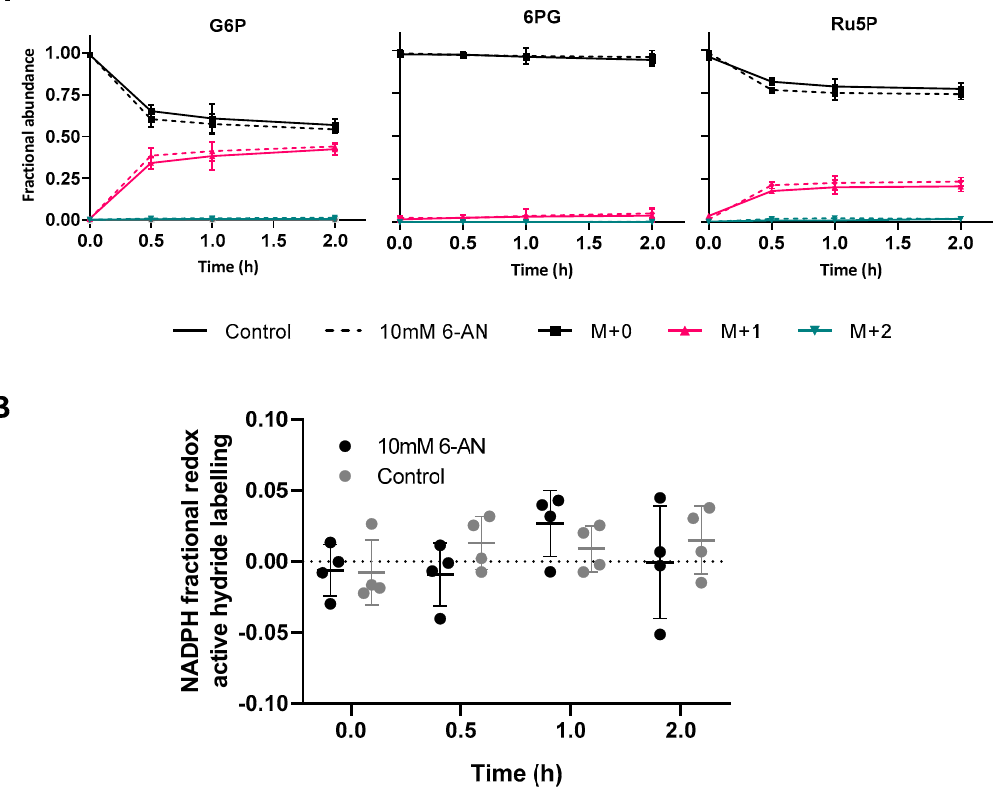
Figure 3. Deuterium labelling of metabolites following transfer of heterotrophic cells to 100% [1- 2 H]glucose media. ( A ) MIDs of metabolites after incubation of Arabidopsis cell cultures with (—) or without (–) 10 mM 6-AN for 20 h before transfer to 100% [1- 2 H]glucose media for up to 2 h. Samples were analysed using Zic-cHILIC chromatography, Xevo G2 XS MS and corrected for natural abundance using IsoCor [43]. Values are the mean ± SD, n = 4. ( B ) The effect of 6-AN on NADPH redox active hydride labelling calculated by deconvolution of NADP + and NADPH MID. Cells were incubated with ( • ) or without( • ) 10 mM 6-AN for 20 h before transfer to 100% [1- 2 H]glucose media and extracted over 2 h. Samples were analysed using Zic-cHILIC chromatography and Xevo G2 XS MS. Each point is a single biological replicate. Error bars are SD.